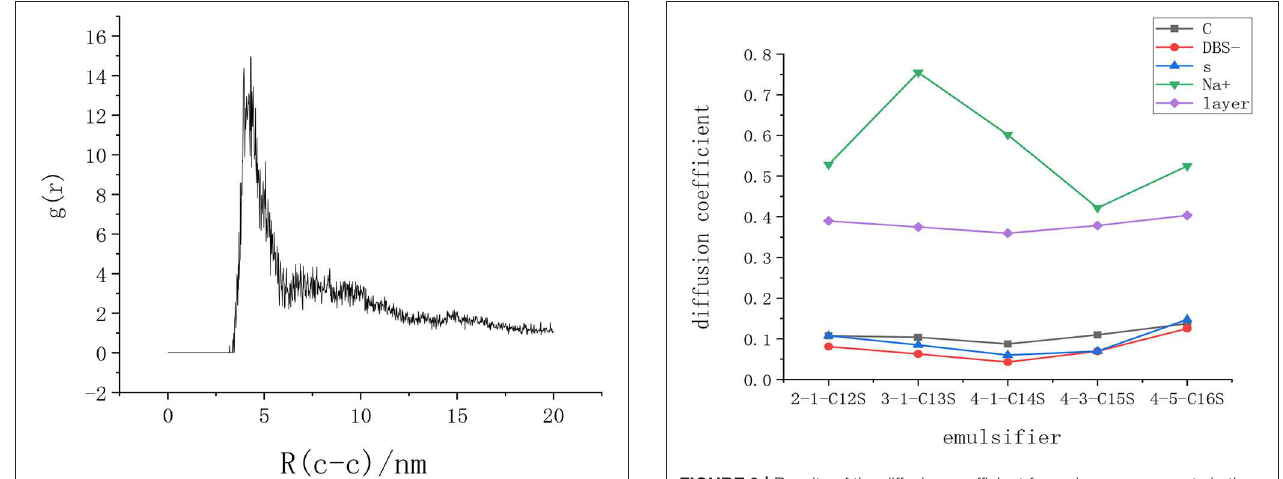
FIGURE 9 | Results of the diffusion coefficient for various components in the